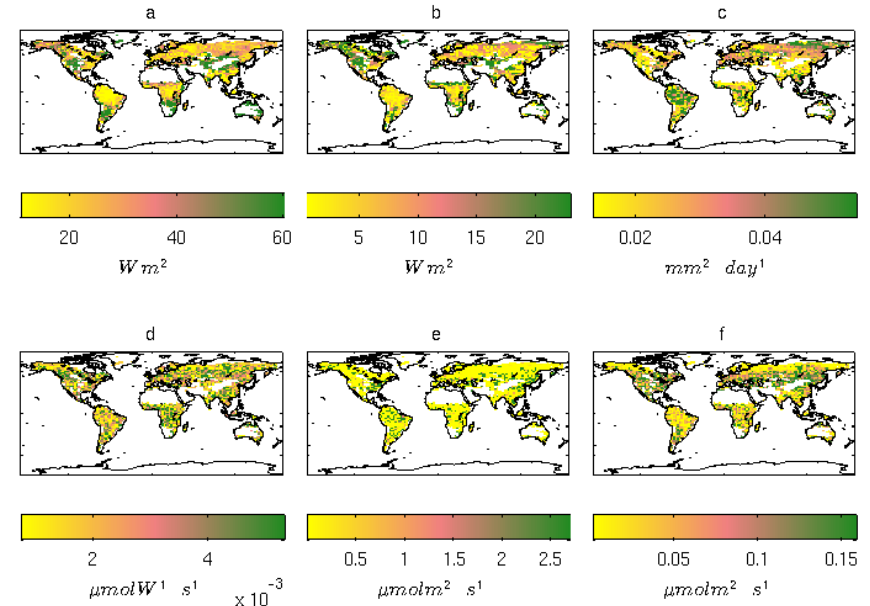
Fig. A1. Posterior parameter values describing leaf gain and carbon assimilation: (a) direct compensation point, C direct , (b) diffuse compen- A min .